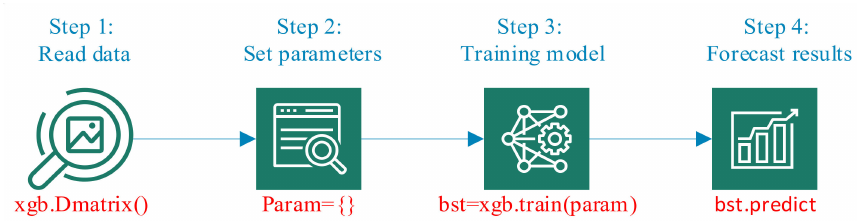
Figure 2. XGBoost algorithm flow chart.